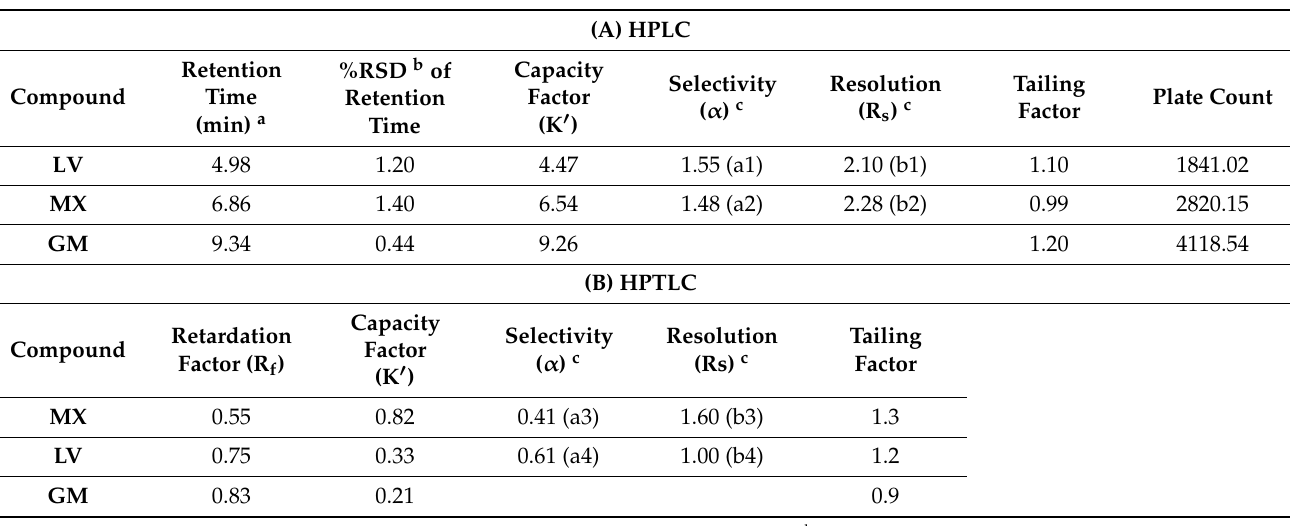
Table 1. The system suitability test results of the developed (A) HPLC method and (B) HPTLC for determination of the selected